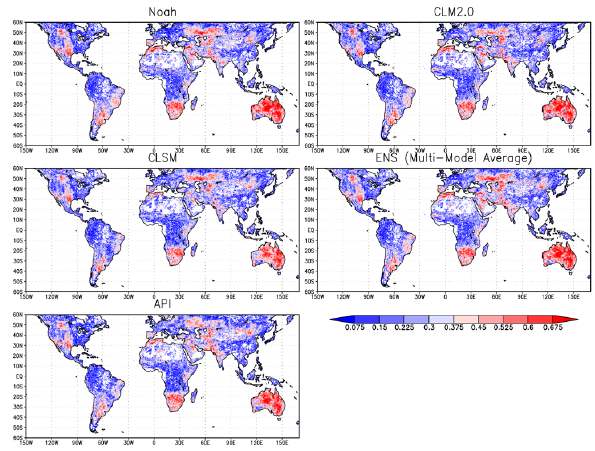
Fig. 3. Quasi-global map of 0.25 ◦ R( − 1 ) for the Noah, CLM2.0, CLSM, ENS, and API